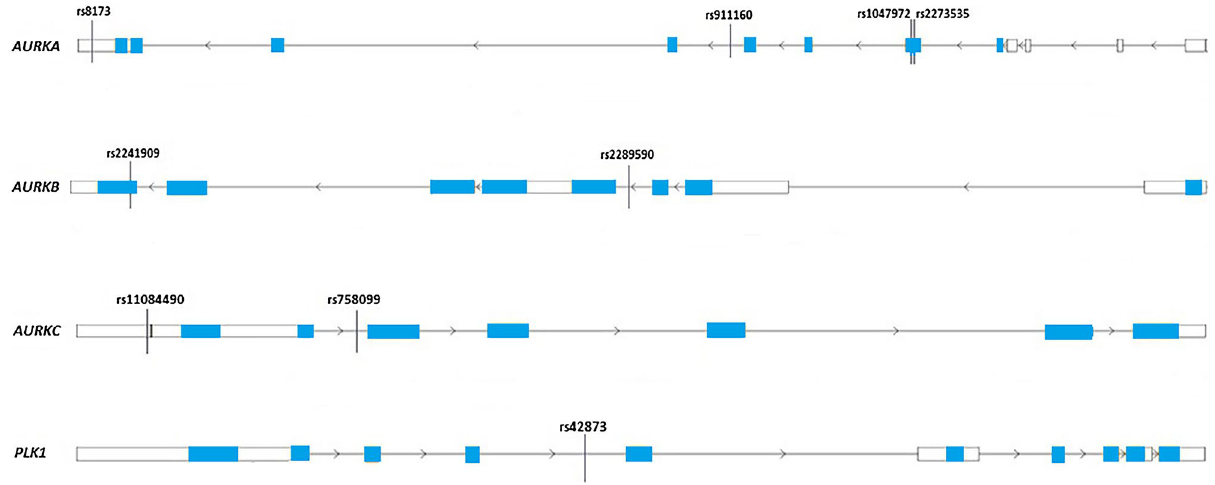
Figure 1. The positions of rs1047972, rs2273535, rs8173 and rs911160 ( AURKA ), rs2289590 and rs2241909 ( AURKB ), rs11084490 and rs758099 ( AURKC ) and rs42873 ( PLK1 ) genetic variants within mitotic checkpoint genes. White boxes represent untranslated regions (UTRs). Blue boxes refer to protein coding regions (exons). The black lines connecting the boxes indicate non-coding regions (introns). The gene structures were